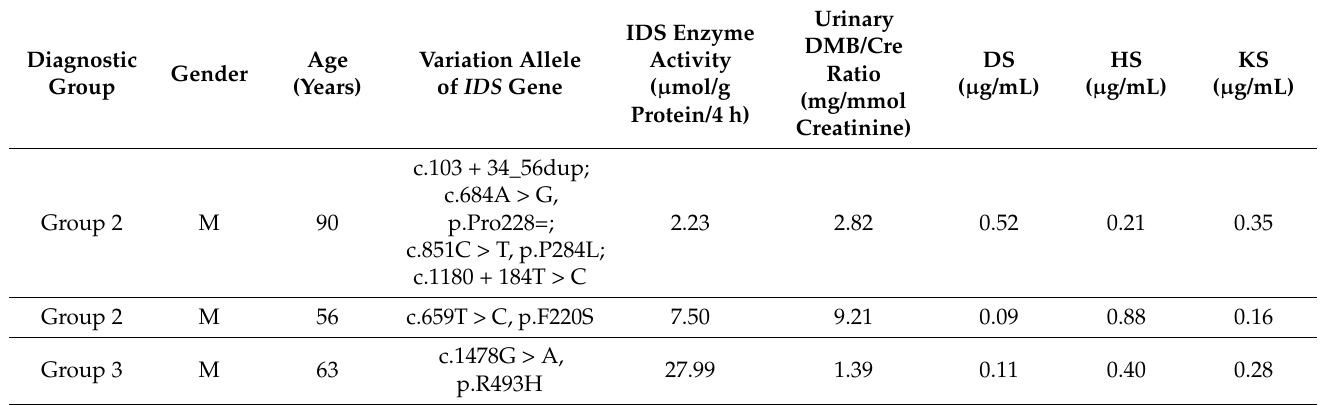
Table 4. Age, IDS enzyme activity, and biochemistry GAG tests of three senior male relatives of the referred infants in our MPS II newborn screening program who were identified to have the same IDS